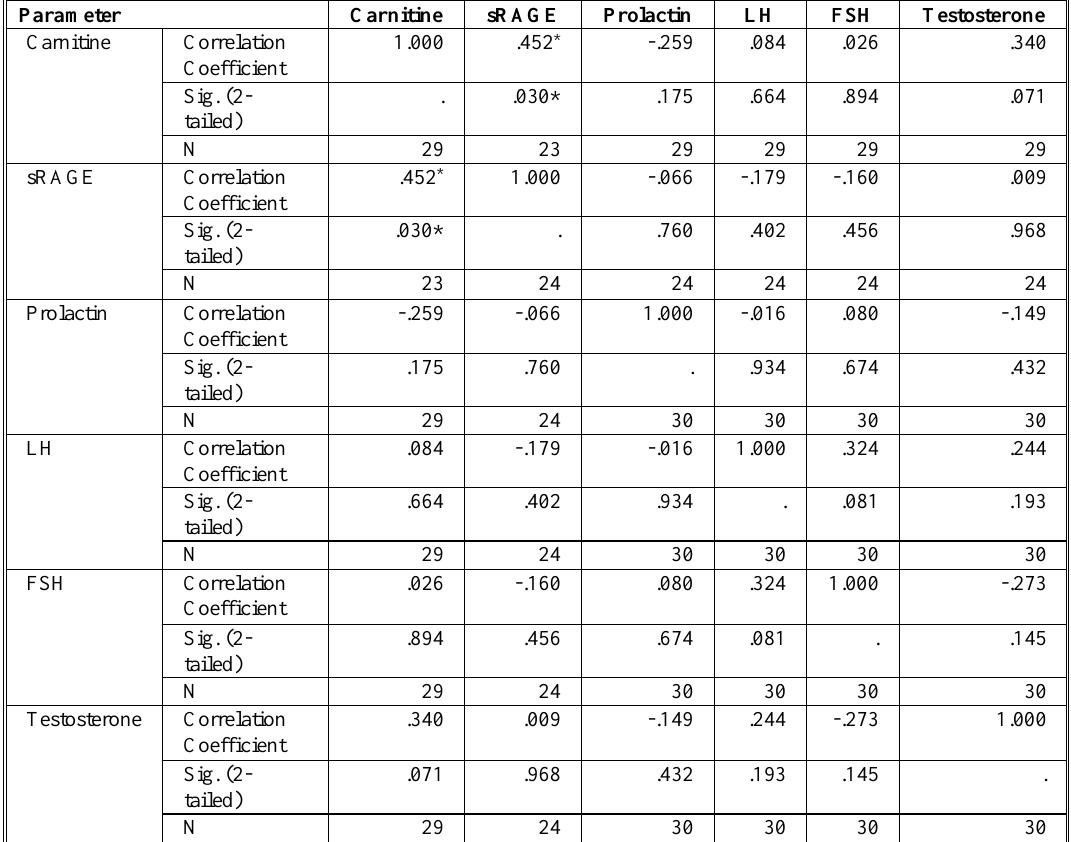
Table 3. Pearson’s correlations between serum carnitine and s RAGE with sex hormones in patients group Parameter